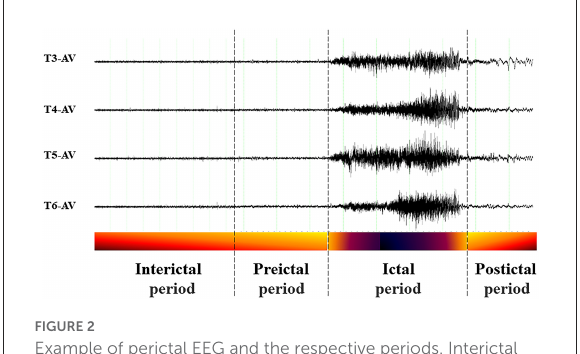
FIGURE2 Example of perictal EEG and the respective periods. Interictal period: away from seizures; Preictal period: immediate before a seizure; Ictal period : spans the seizure itself; Postictal period: immediate after a